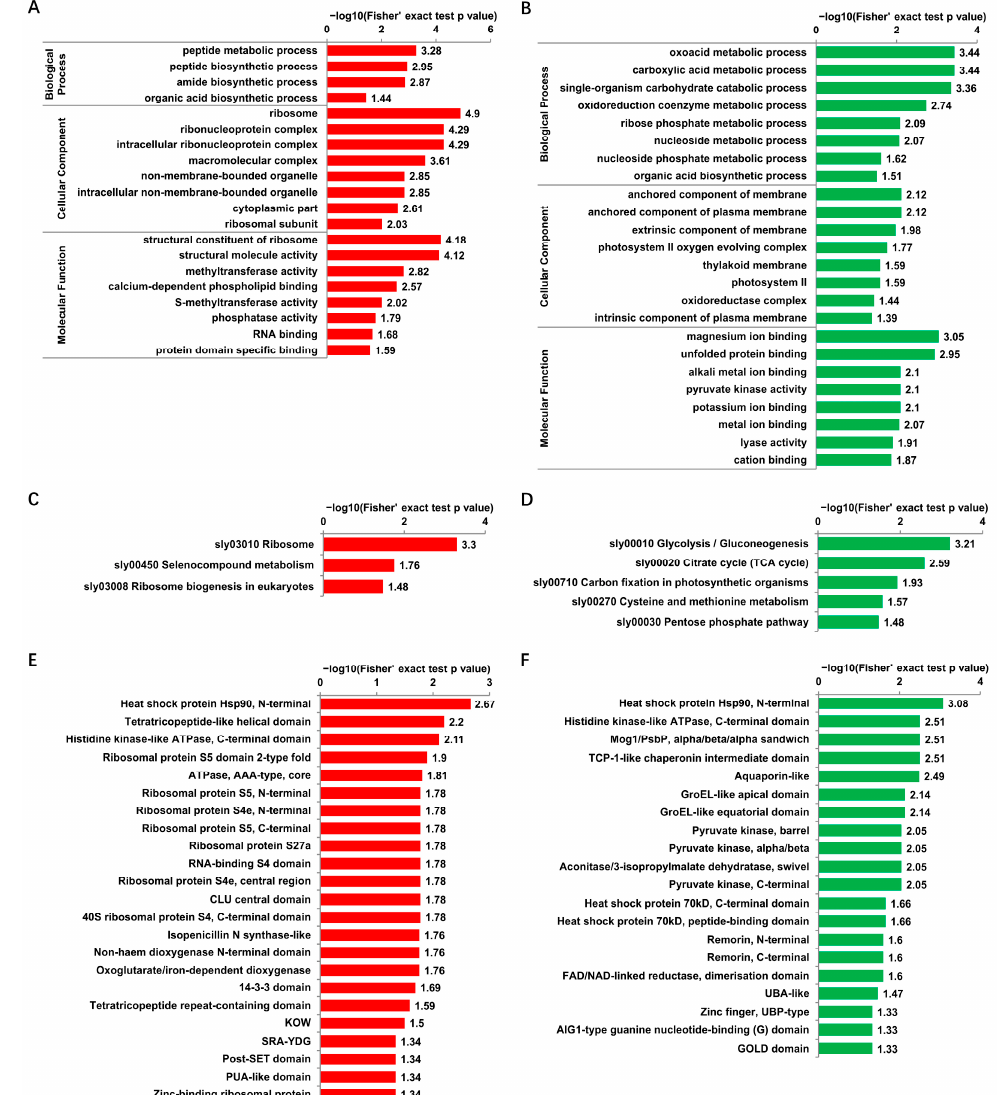
Figure 4. Functional enrichment analysis of identified proteins with DUSs. ( A , B ) GO enrichment analysis of proteins with up-regulated Kub sites ( A ) and down-regulated Kub sites ( B ) in “biological process category”, “cellular component category”, and “molecular function category”. ( C , D ) KEGG enrichment analysis of proteins with up-regulated Kub sites ( C ) and down-regulated Kub sites ( D ). ( E , F ) Protein domain enrichment analysis of proteins with up-regulated Kub sites ( E ) and down- regulated Kub sites ( F ).